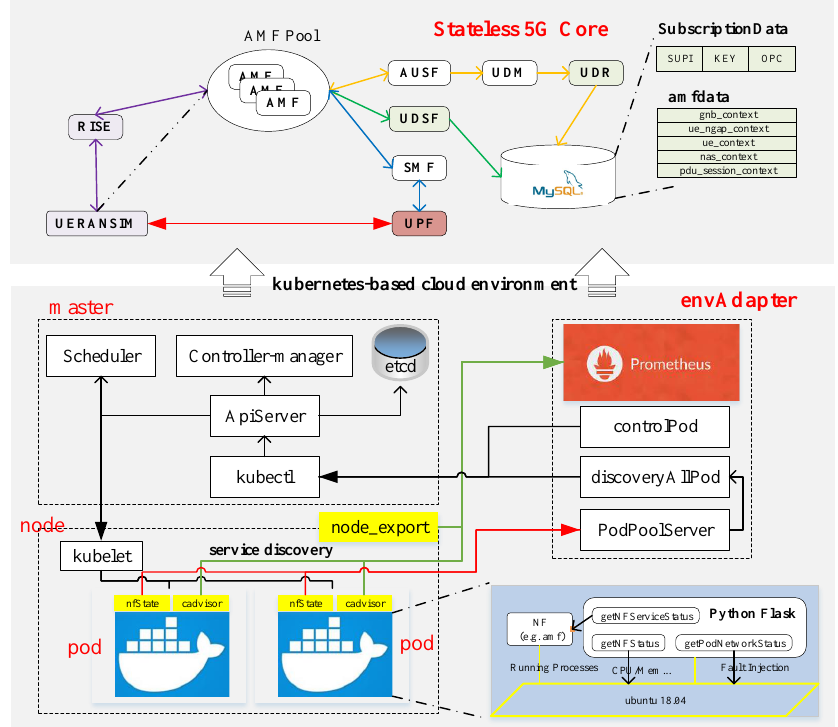
Figure 2. Kubernetes-based cloud